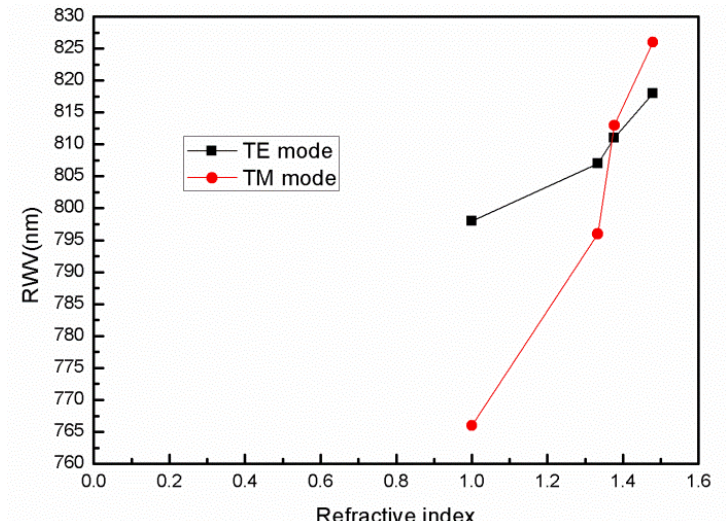
Figure 4. Sensitivity of the TE mode and TM